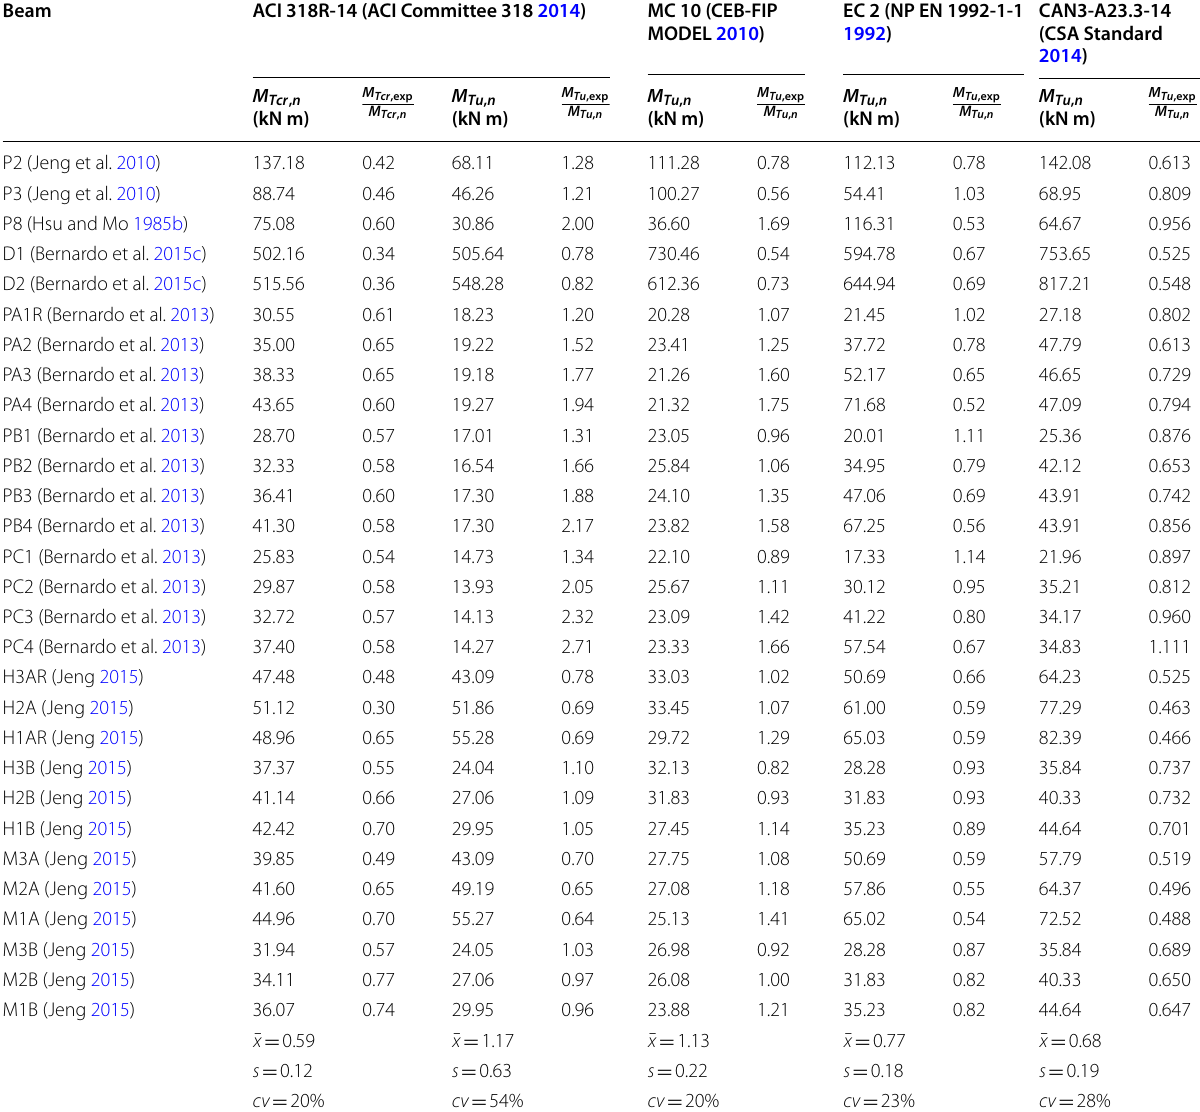
Table 5 Comparative analysis for the cracking and ultimate torques—codes of practice.